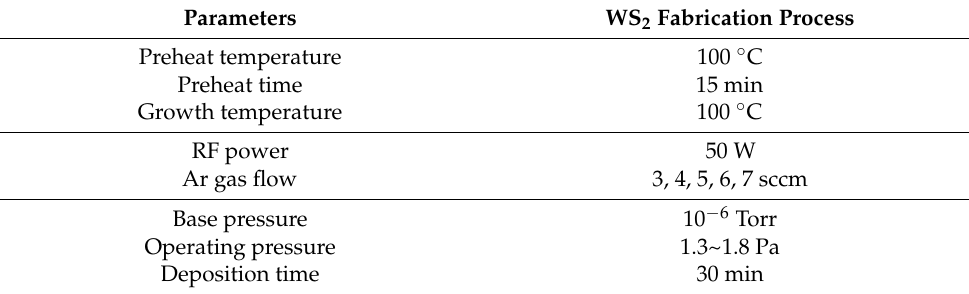
Figure 1. Schematic diagram of RF magnetron sputtering system. Table 1. WS 2 fabrication